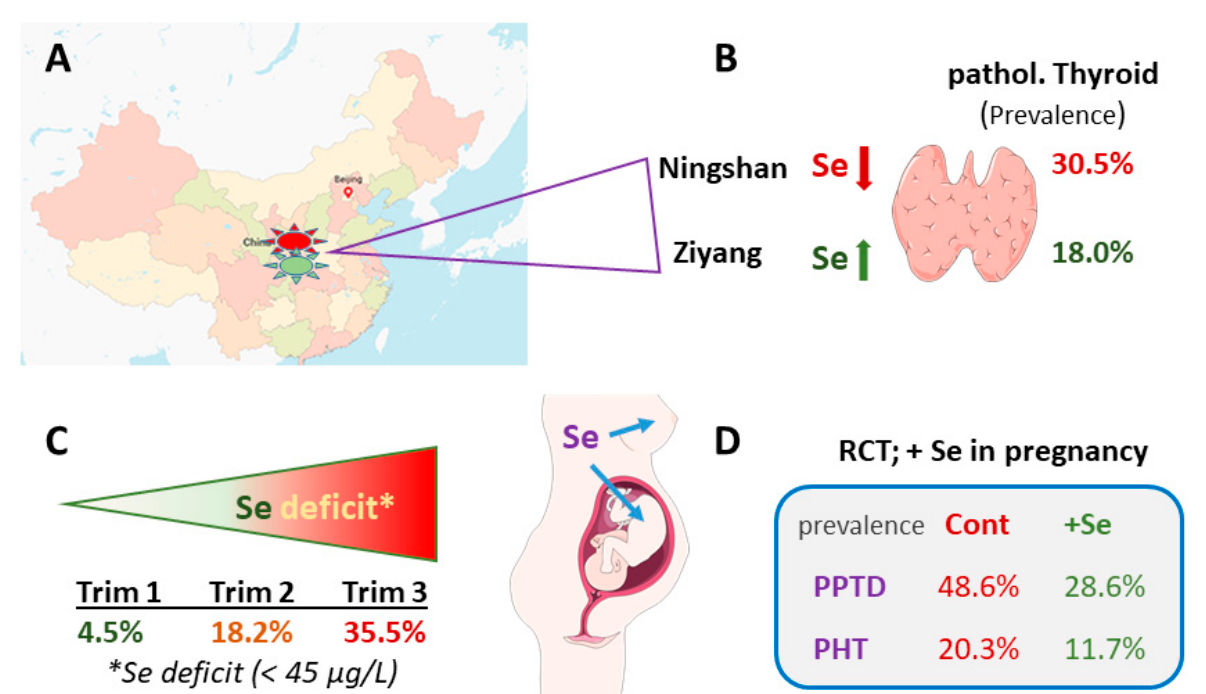
Figure 3. Importance of Se deficiency as druggable risk factor for AID. ( A ) High thyroid disease prevalence (pathol. Thyroid; goiter, (sub-) clinical hypothyroidism or autoimmune thyroiditis) is observed under low baseline Se intake. ( B ) The population on low Se intake (Ningshan) had an almost twice-higher incidence of thyroid disease as compared to the population with higher Se intake (Ziyang). ( C ) During pregnancy, Se status in the pregnant mothers decline from trimester 1 (Trim 1) to Trim 3, causing a severe Se deficit (<45 µg/L) in one-third of pregnancies in a European observational study. ( D ) Supplemental Se during pregnancy was capable of suppressing the high incidence of postpartum thyroid dysfunction (PPTD) and permanent hypothyroidism (PHT) in predisposed women ca. two-fold.